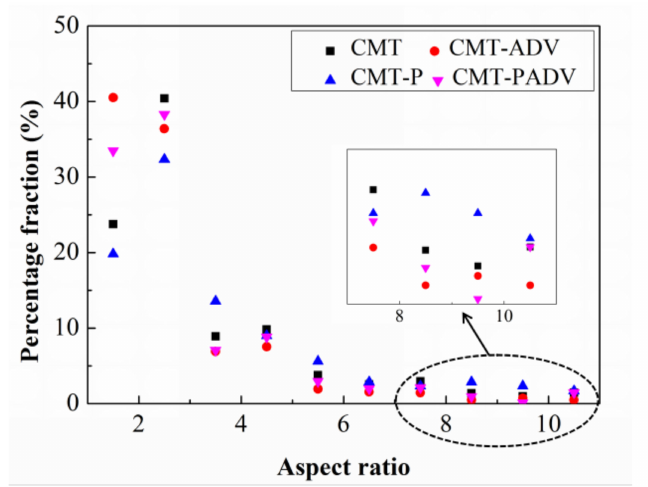
Figure 7. Pore aspect ratio distribution in percentage fraction for the 2219 aluminum alloys fabricated in different arc